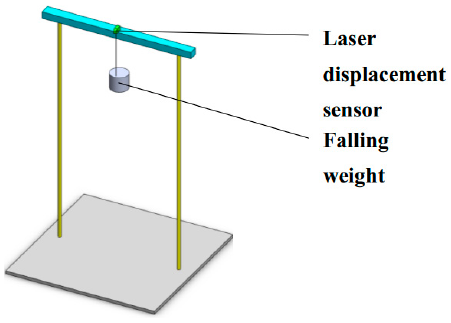
Figure 2. Hardware principle of TPMM.